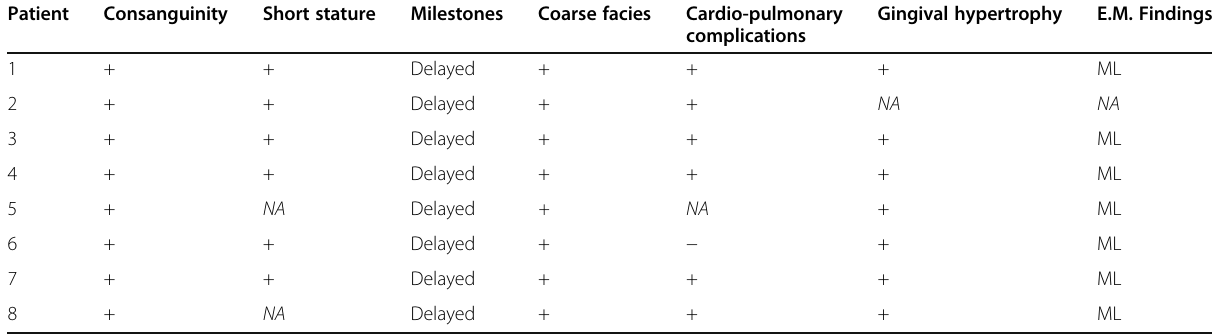
Table 1 Clinical data of the 8 studied patients